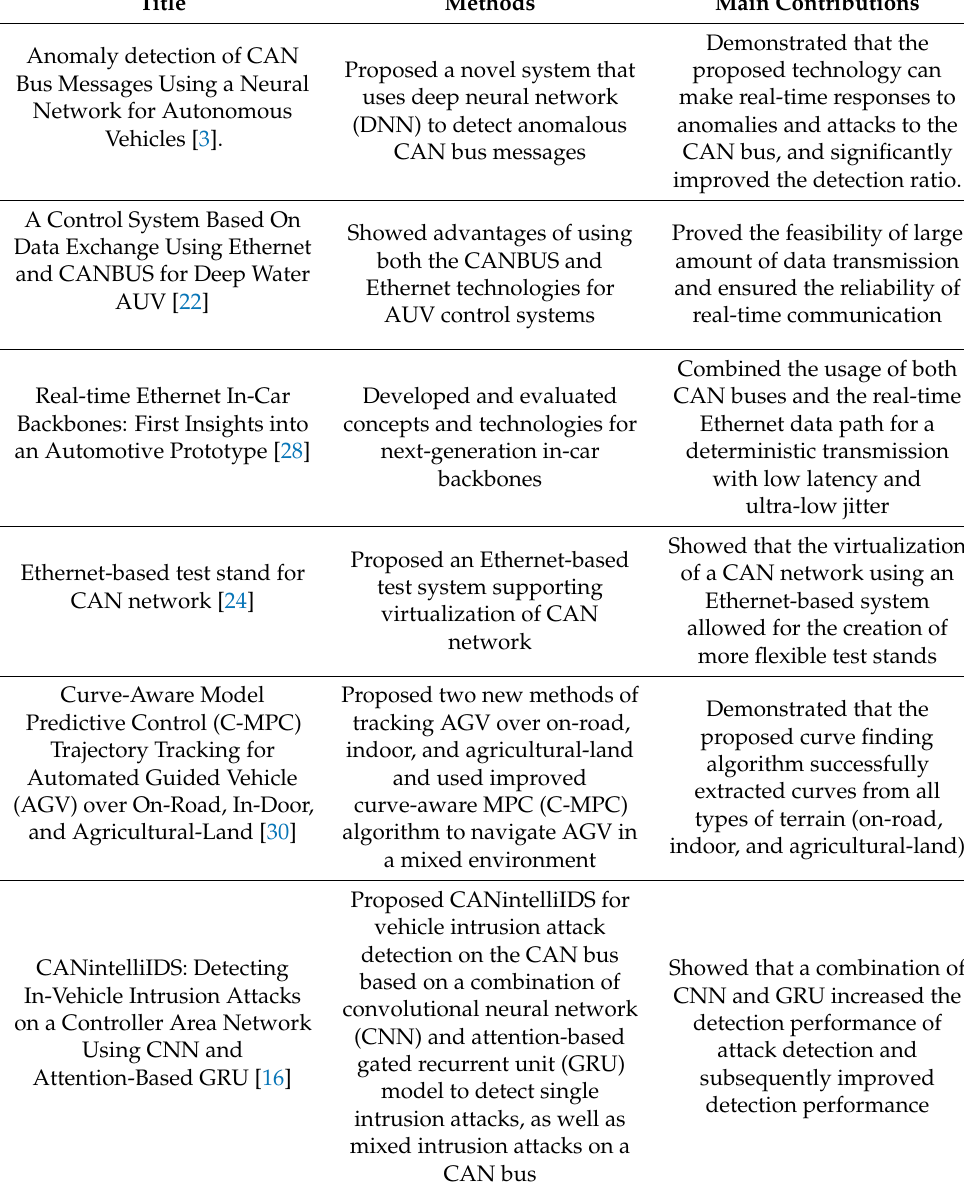
Table 1. Recent work